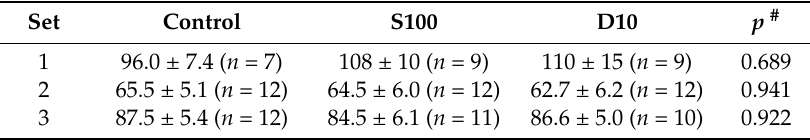
Table 2. Mean number of apoptotic events (±SEM) obtained in the control, S100 and D10 groups from 3 sets of experiments. n : numbers of embryos involved in the analyses. # p values obtained using ANOVA.